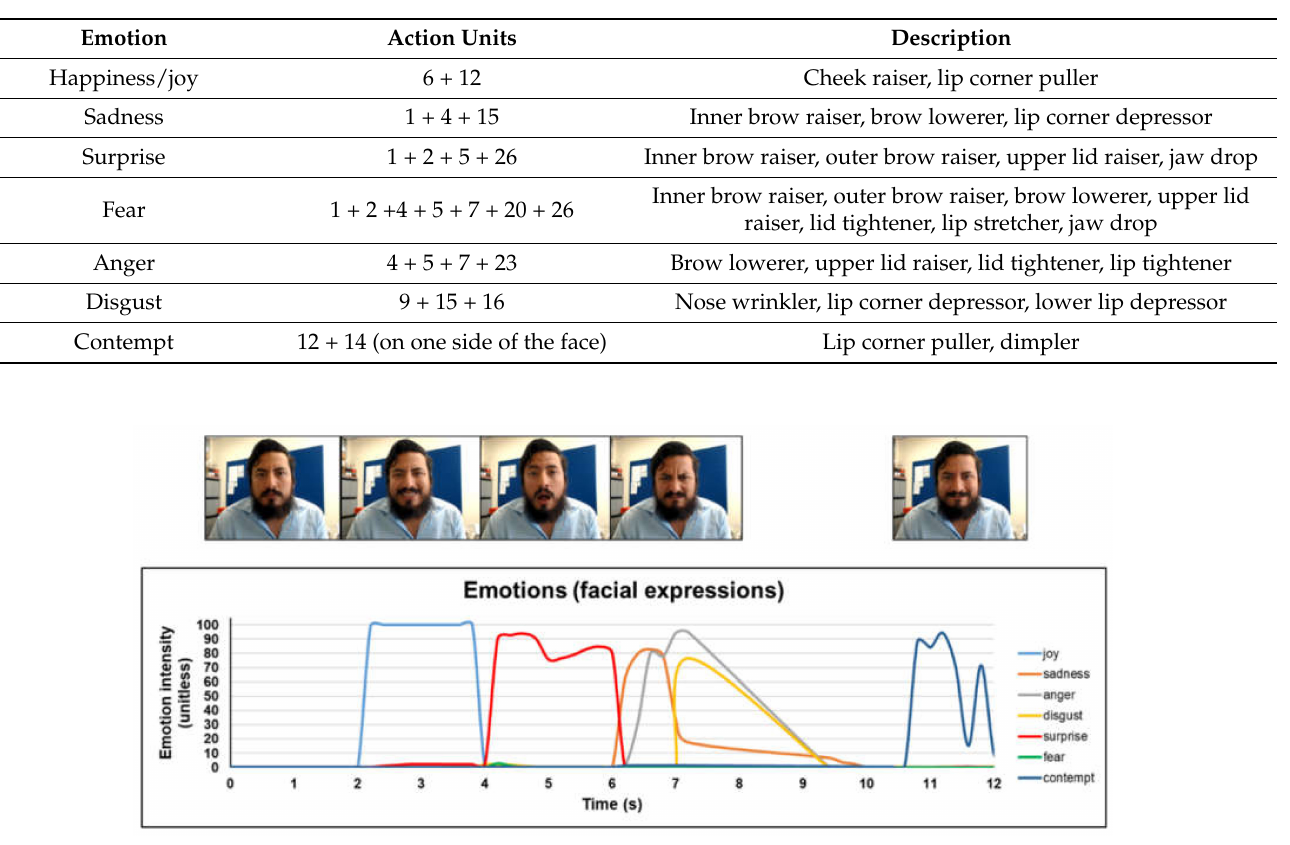
Figure 1. Different emotions: sadness, happy (joy), surprise, disgust, anger, fear, and contempt elicited by a participant. This figure shows 12 s of recording as a demonstration of the different faces’ movements and their relationship with emotions. Actual facial expressions were taken during three seconds after swallowing the